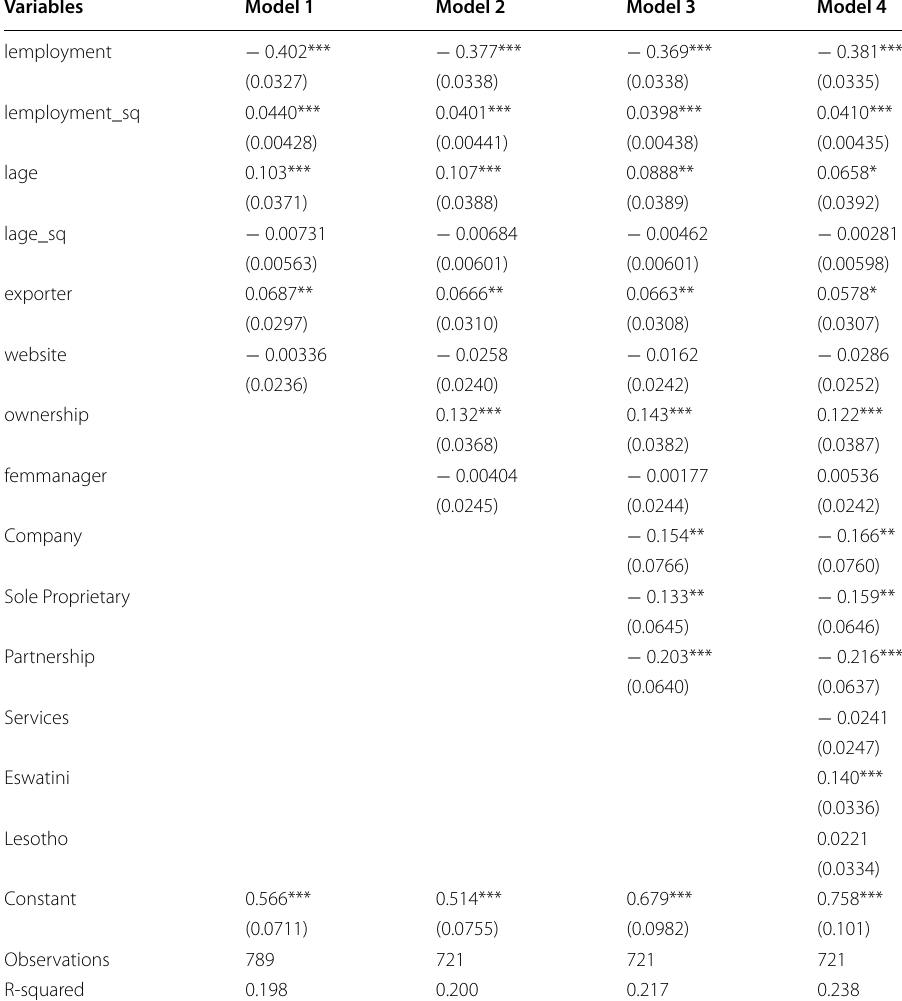
Table 3 Determinants of employment growth-alternative ICT